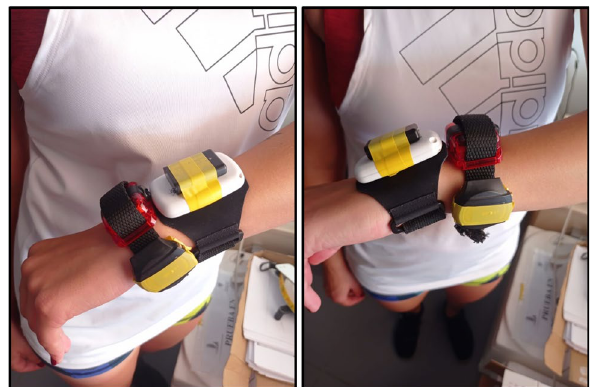
Figure 3. Attachment of the devices in two wristbands. The proximality of the wristbands was counterbalanced across